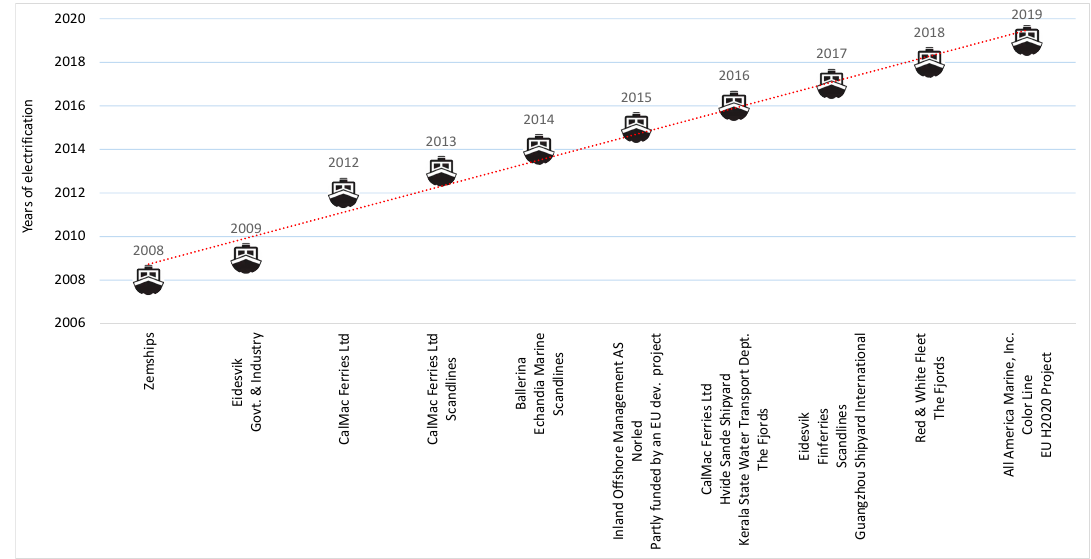
Figure 6. Electric and hybrid vessels (Battery capacity and vessel length). The battery capacity used in pure electric vessels is in the range of 50–500 kWh, with a median value of 140 kWh, while, in hybrid ships, the range is 500–5000 kWh, with a median of 1000 kWh. From the analysis, it is clear that hybrid technology (used in 69% of the vessels) has an almost 10 times larger battery capacity compared to the pure electric vessels. The pure electric vessel length is in the range of 21–39 m, with a median at 22 m, while the hybrid ship lengths are in the range of 40– 160 m, with a median of 84.5 m. The difference between lengths is at least twice at minimum range, while this difference in size becomes four times at maximum values. Finally, the green dotted line shows the trend of battery capacity in kWh for different electric and hybrid vessels, and the red dotted line shows the trend of vessel length for various electric and hybrid vessels. Similar to Figure 6, Figure 7 classifies the pure electric and hybrid technology on the basis of three parameters: (1) passengers capacity, (2) car carrying capacity, and (3) the maximum speed of the vessel. The figure has a dual scale; the passenger and car capacity are shown on the left side of the graph, while the vessel speed in knots is shown on the right side of the graph. It is obvious from Figure 7 that the passenger capacity of pure electric vessels is in the range of 75–1250, with a median